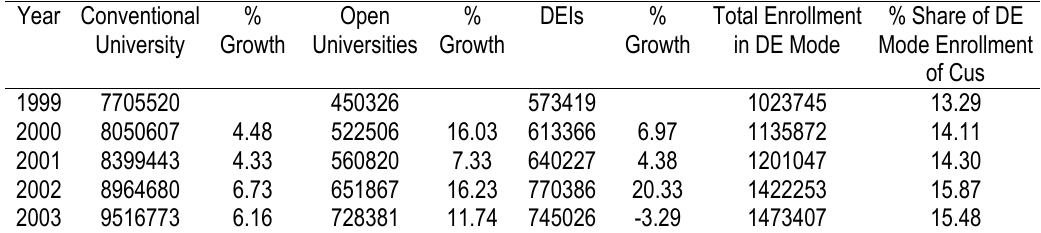
Table1. Comparative Analysis of Trend in Enrollment in Conventional Universities, Open Universities and DEI Year Conventional Open University Growth Universities Mode